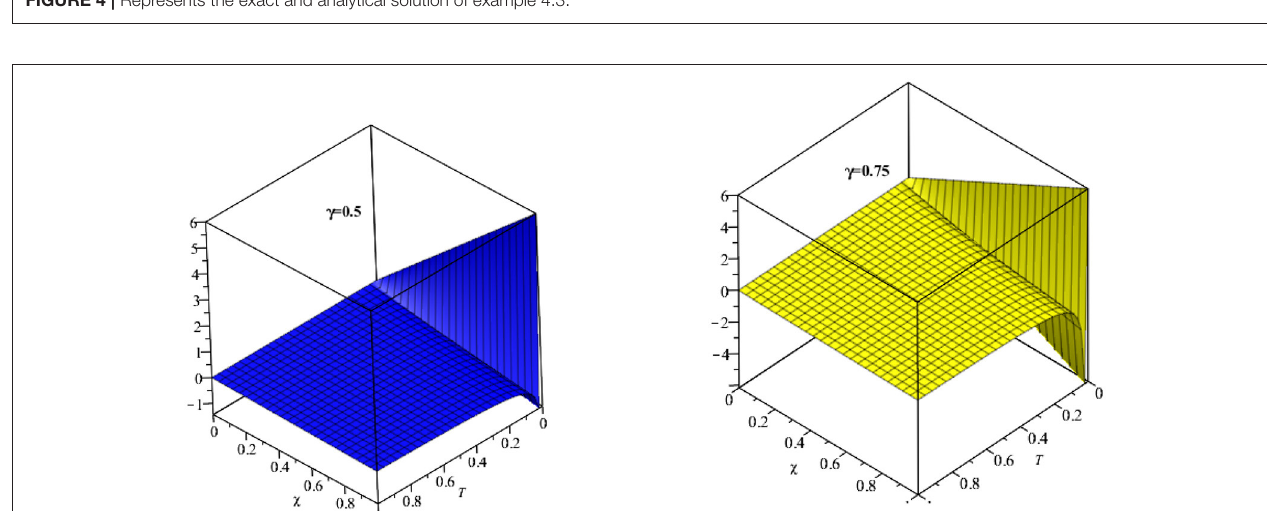
FIGURE 4 | Represents the exact and analytical solution of example 4.3.